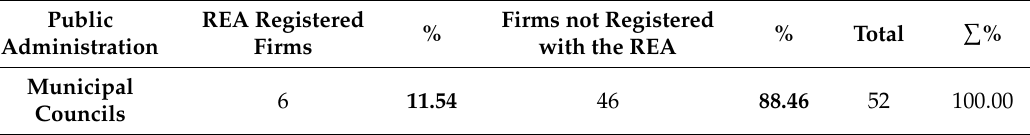
Table 4. Municipal Councils in the present research registered with the REA, values updated until 02 / 13 / 2017. Where: 100% = 52 Municipal Councils in national territory. Source : Ministerio de Hacienda